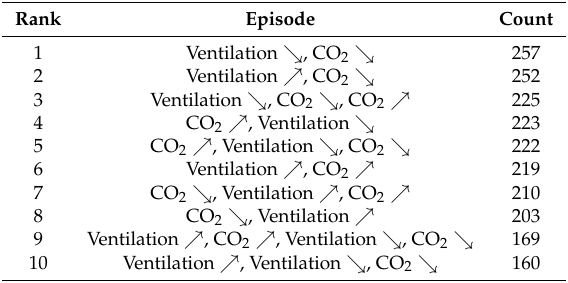
Table 3. Most frequent episodes in database for ventilation unit 1.